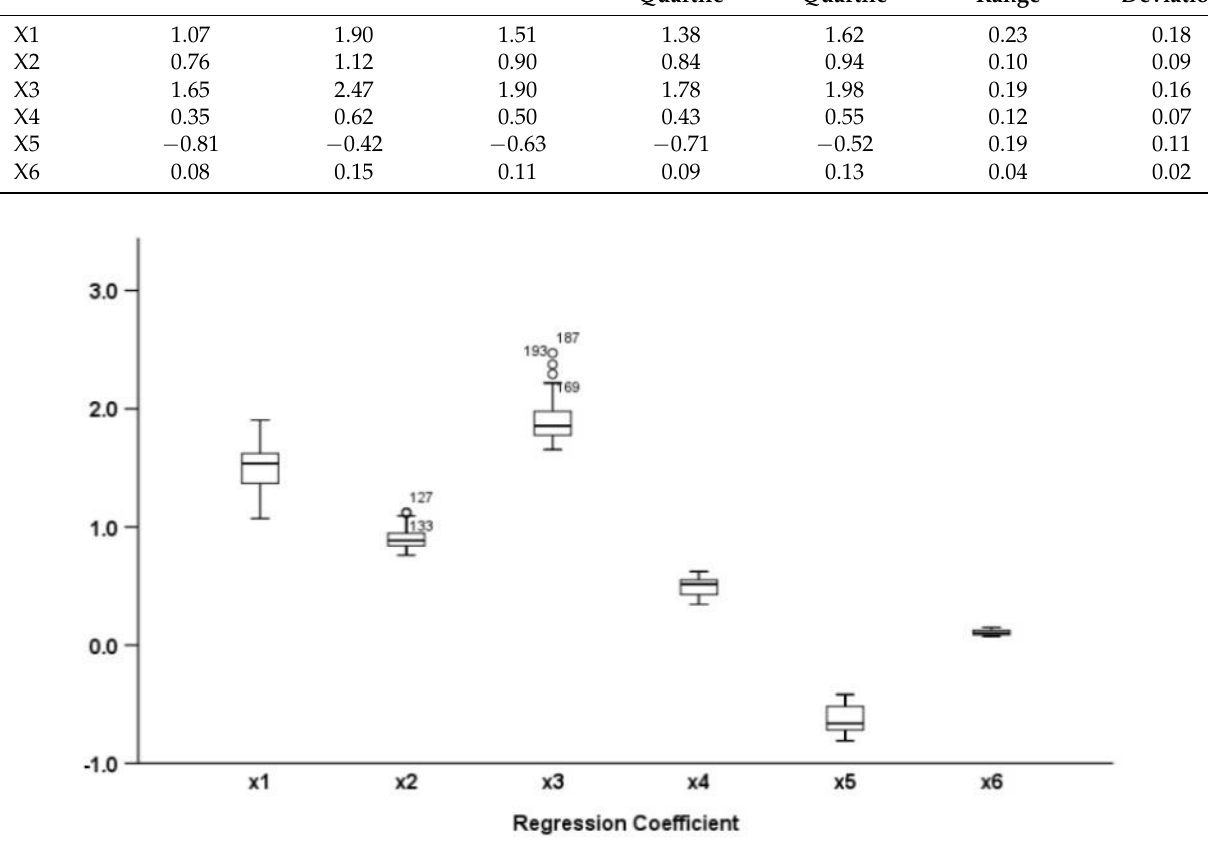
Figure 3. Box plot of regression coefficient of various explanatory variables of PGTWR model.